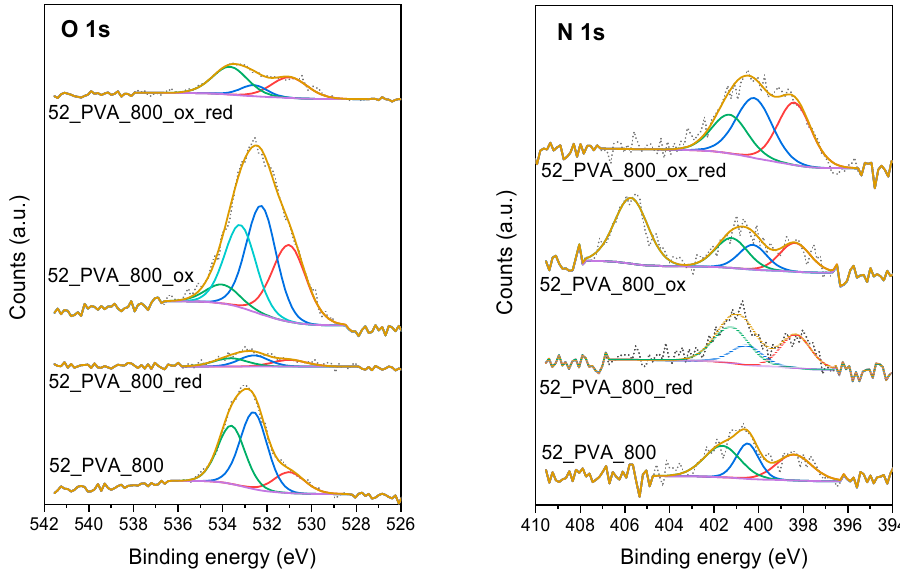
Figure 7. High-resolution O 1s and N 1s XPS spectra for the resol resin-derived carbon materials carbonized at 800 °C and subsequently modified in an oxidizing/reducing atmosphere.